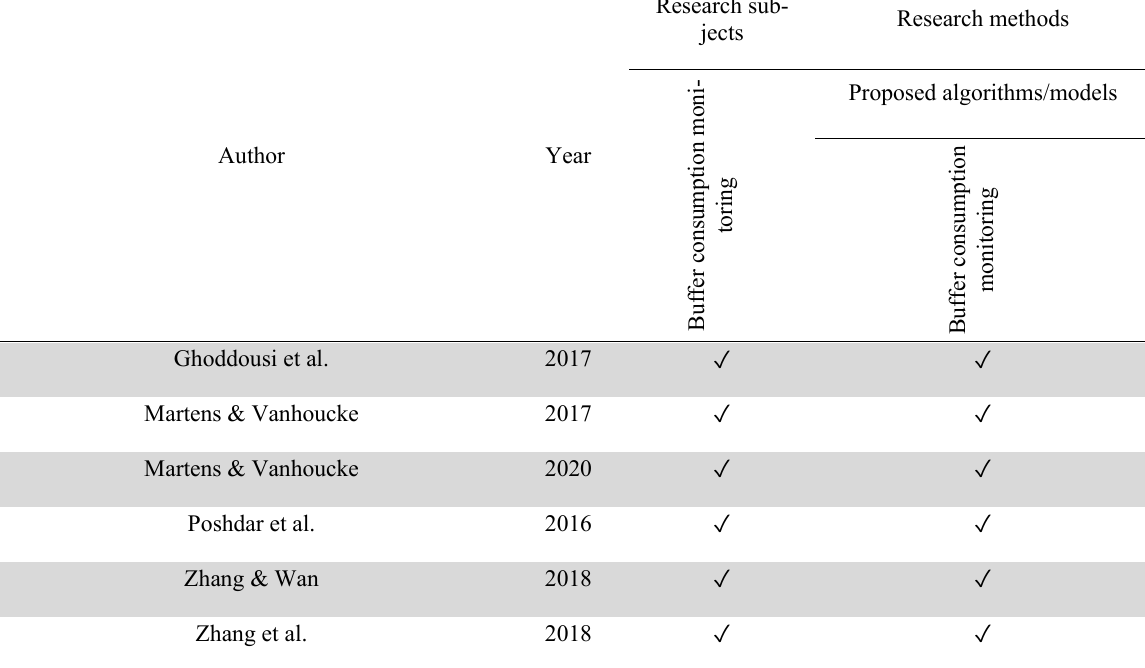
Project buffer consumption monitoring: Proposed